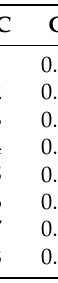
Table 1. Accuracy of the spectral retrieval as a function of principal components (averages values of metrics). GFC, goodness-of-fit